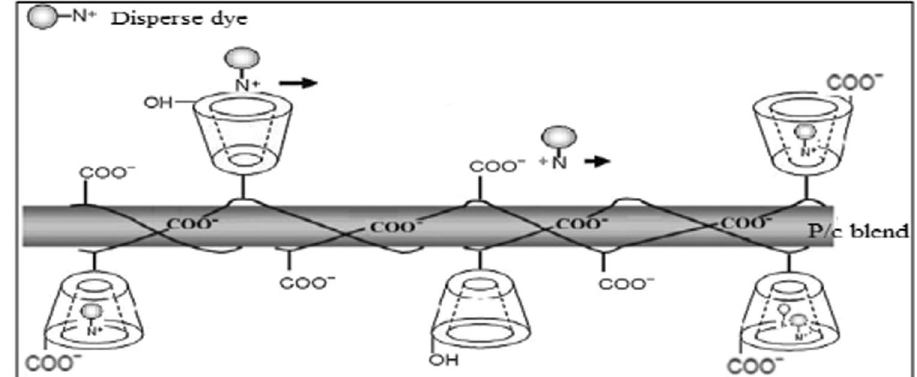
Fig. 9 Schematic of the dye- ing process